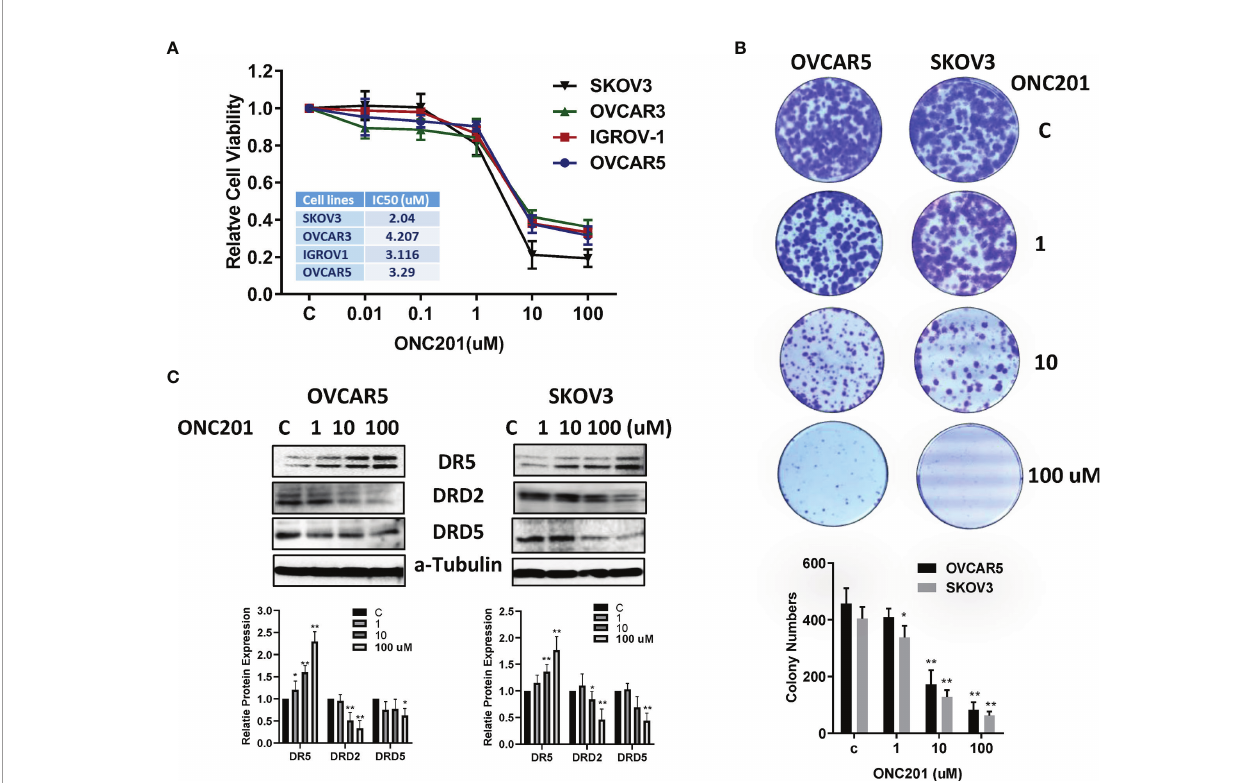
FIGURE 1 | ONC201 inhibited cell viability and colony formation. The OVCAR5, OVCAR3, IGOV-1 and SKOV3 in 96 well plates were treated with increasing concentrations of ONC201 for 72 hours and subjected to the MTT assay. ONC201 signi fi cantly inhibited cell growth in a dose- dependent manner in all cell lines. Similar results were obtained from three independent experiments (A) . ONC201 inhibited colony forming ability of OVCAR5 and SKOV3 cells compared to the vehicle-treated cells. Cells were incubated with ONC201 for 48 hours, then cell were culture in drug-free media for 12 days (B) . The images and bar chart represented results of one experiment. Western Blotting was used to evaluate the effect of ONC201 on expression of DRD2, DRD5 and DR5 in the OVCAR5 and SKOV3 cells. ONC201 decreased the expression of DRD2 and DRD5 and increased the expression of DR5 in a dose-dependent manner in both cell lines (C) . * <0.05, **